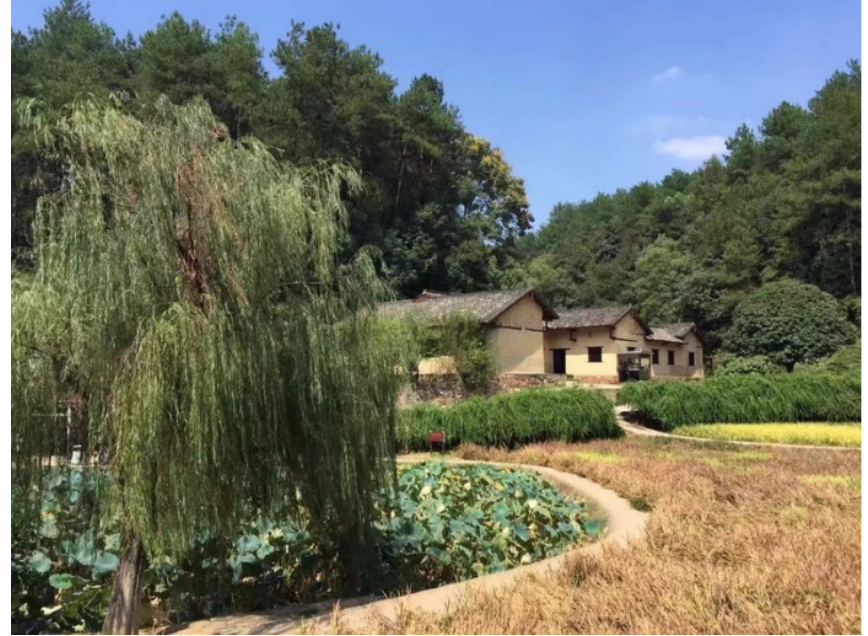
Figure 11. Former residence of Mao Zedong, Shaoshan, NRTTC.